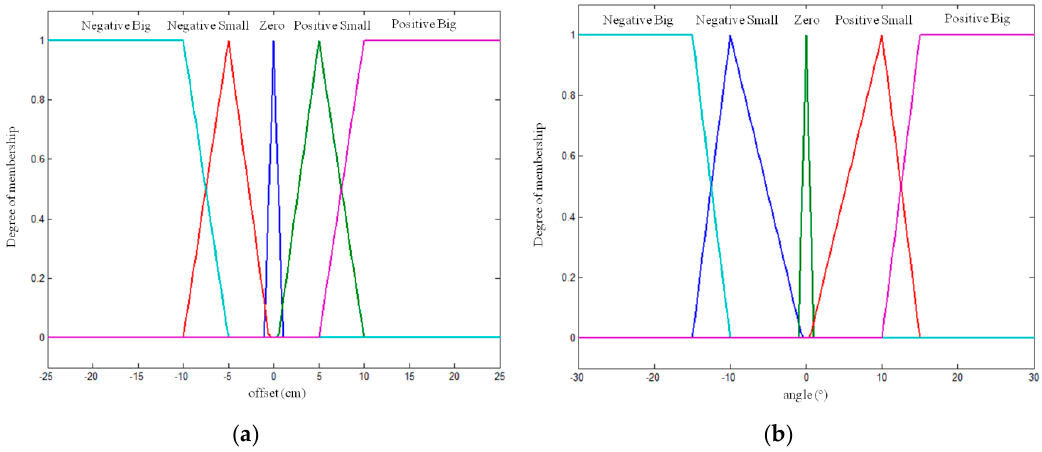
Figure 11. Linear speed controller. Fuzzy sets of input variables: ( a ) offset and ( b ) angle.